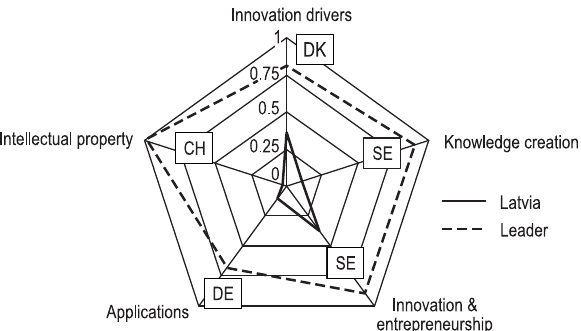
Fig. 7. Innovation performance: Latvia and the European leader (European Innovation ...